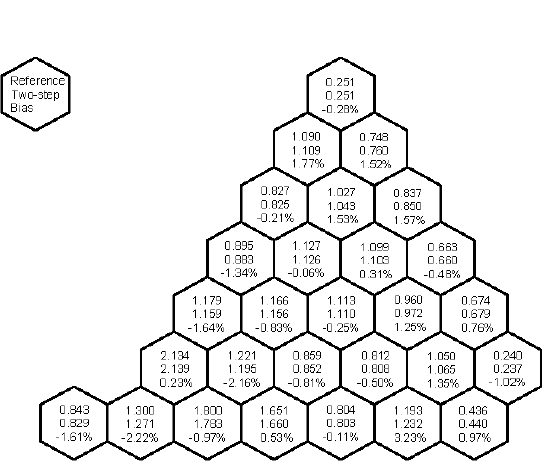
Figure 5. Assembly fission rate distribution of VVER-1000 core at S3